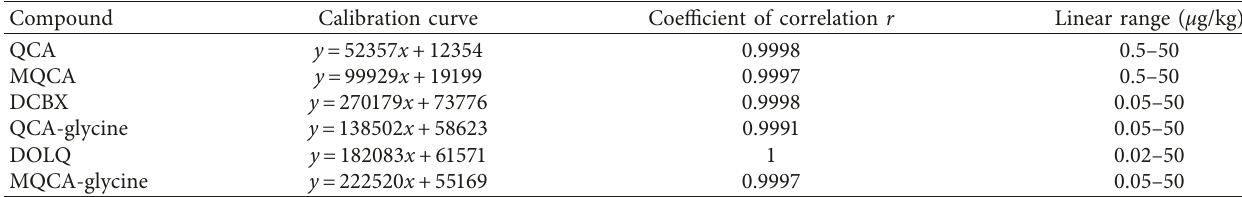
Table 3: Calibration curves of the analytes fortified in the swine liver.